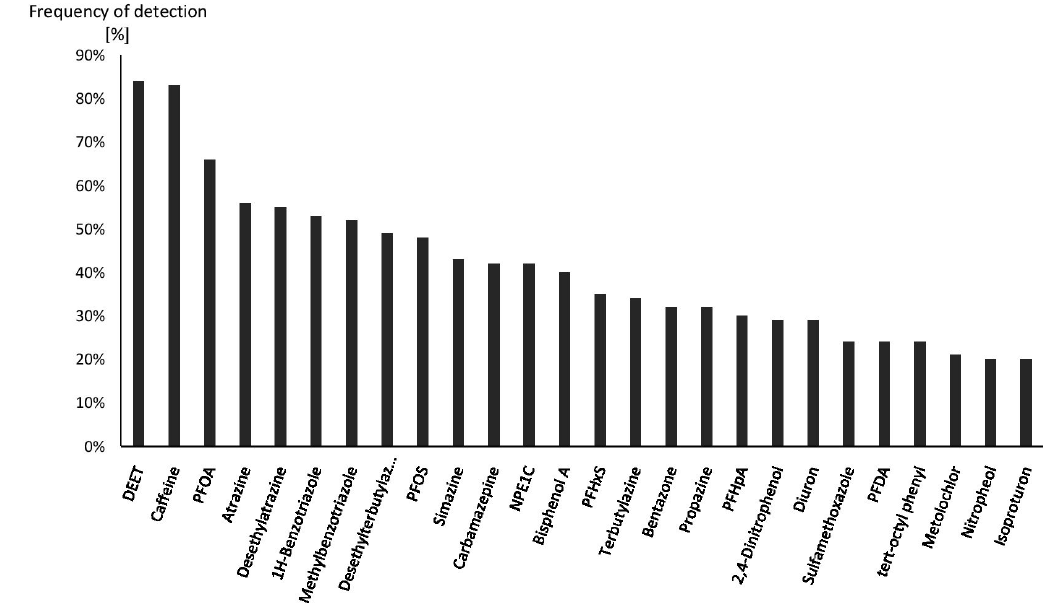
Figure 1: Frequency of detection for compounds present in 20% or more of samples detected by Loos et al. [63]